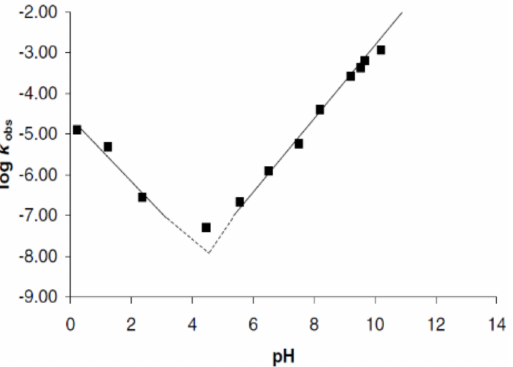
Figure 4. Dependence of the hydrolytic degradation constant ( k obs ) on pH. Reprinted with permission from Ref. [141]. Copyright 2001,